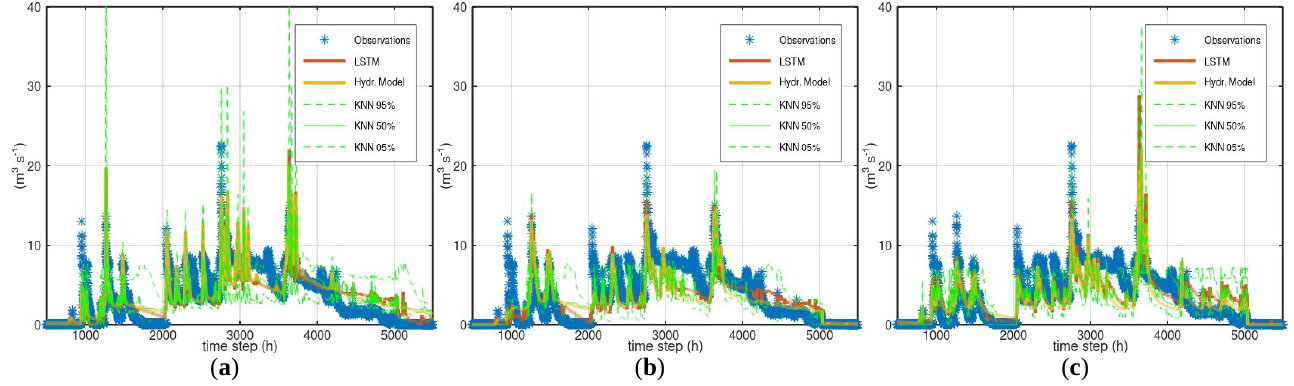
Figure 9. Simulation of Bakas River, for time steps 500–5500 of test period: ( a ) HYMOD; ( b ) LRHM; and ( c ) GR4H (note the “preference” of the upper limit of the CI for a specific value (around 6 m 3 /s)).